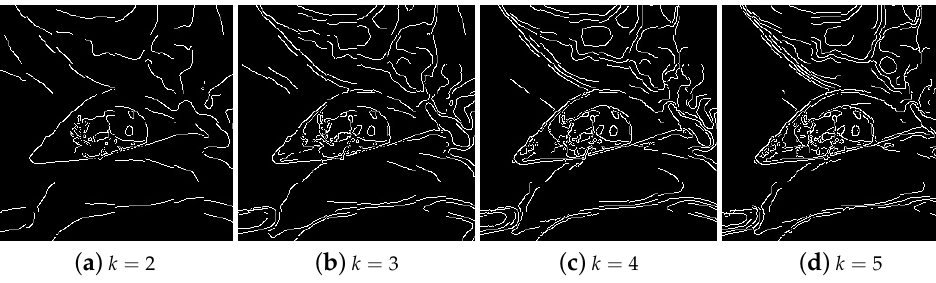
Figure 7. Edges detected by the local k-Means algorithm with different numbers of